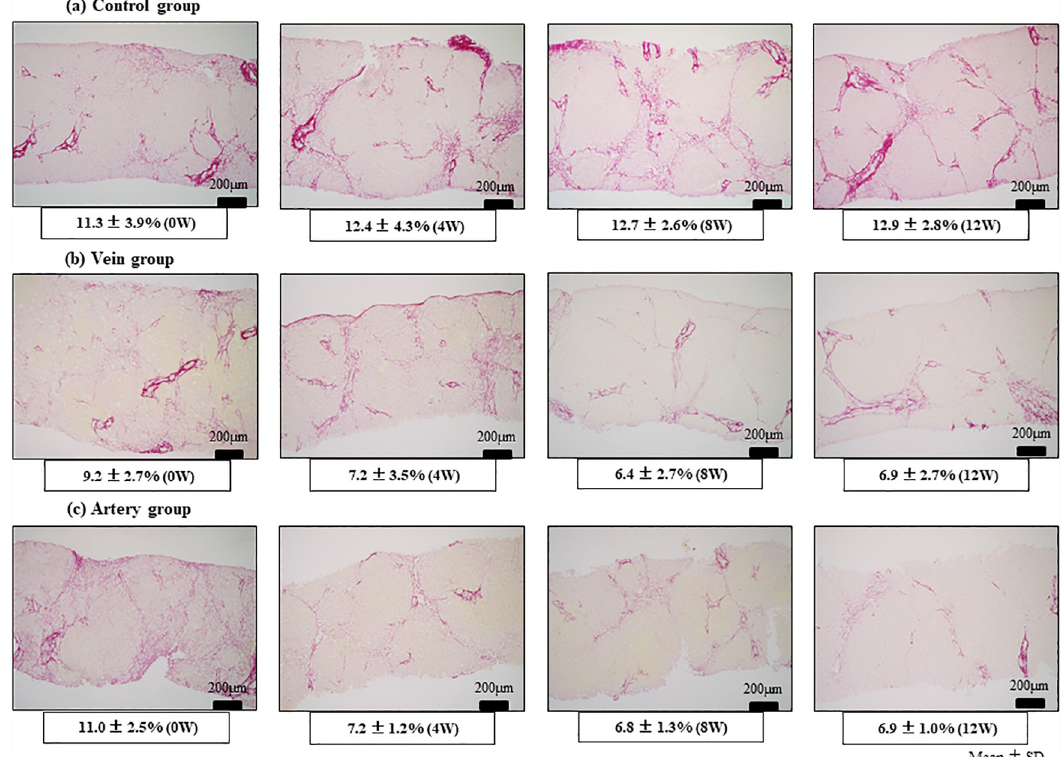
Fig 3. Liver fibrosis in different treatment groups as assessed by Sirius-red staining. The canines were administered repeated carbon tetrachloride (CCl 4 ) injections to induce liver fibrosis and treated with bone marrow-derived mesenchymal stem cells (BMSCs) via the peripheral vein (Vein group) or hepatic artery (Artery group). (a) In the Control group, the fibrosis level increased over time from 11.3 ± 3.9% (0W) to 12.4 ± 4.3% (4W), 12.7 ± 2.6% (8W), and 12.9 ± 2.8% (12W). (b) In the Vein group, the fibrosis level decreased from 9.2 ± 2.7% (0W) to 7.2 ± 3.5% (4W), 6.4 ± 2.7% (8W), and 6.9 ± 2.7% (12W). (c) In the Artery group, the fibrosis level decreased significantly from 11.0 ± 2.5% (0W) to 7.2 ± 1.2% (4W; p < 0.05), 6.8 ± 1.3% (8W; p < 0.05), and 6.9 ± 1.0% (12W; p < 0.05). 4W, 8W, and 12W denote weeks post-BMSC